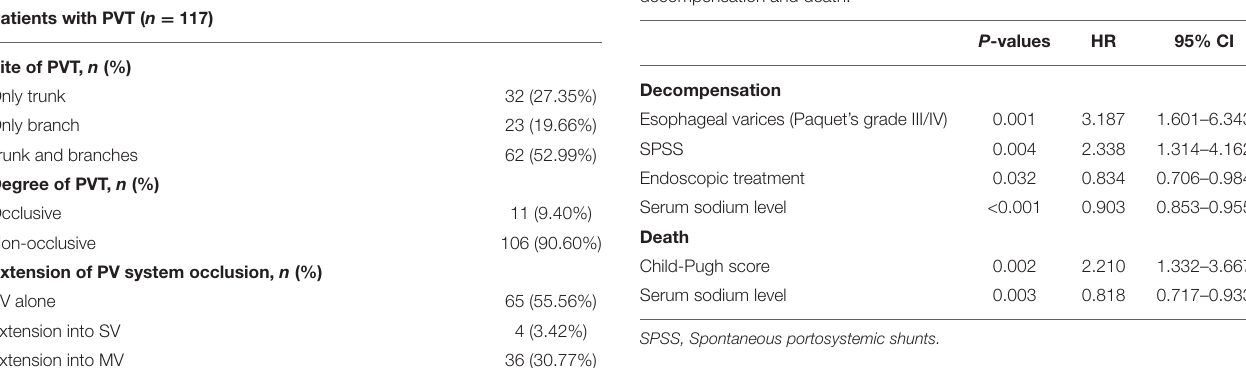
TABLE 2 | Multivariate analysis to determine predictive factors for decompensation and death.